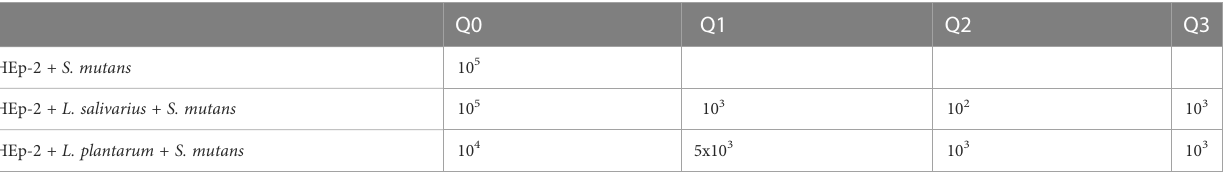
TABLE 2 S. mutans adherence.